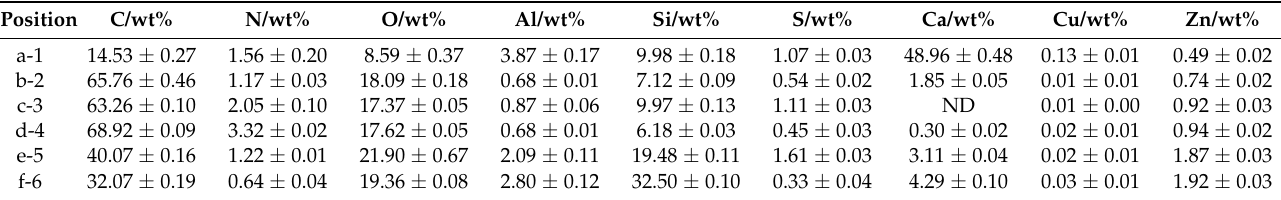
Table 4. Chemical compositions determined by EDS of crystals.